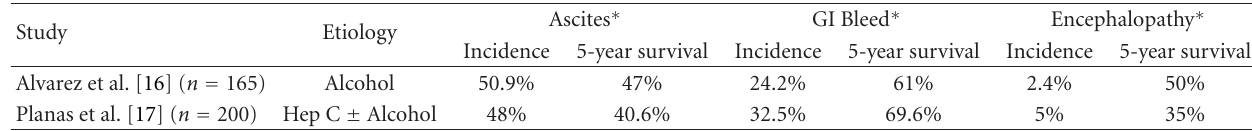
Table 1: Presentation of decompensation and